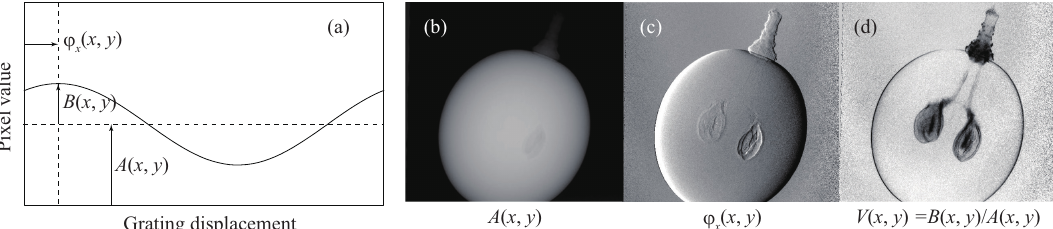
Figure 4. ( a ) Phase-stepping curve expressed by A ( x , y ) , B ( x , y ) , and ϕ x ( x , y ) . Images of ( b ) absorption, ( c ) differential phase, and ( d ) visibility obtained with X-rays for a